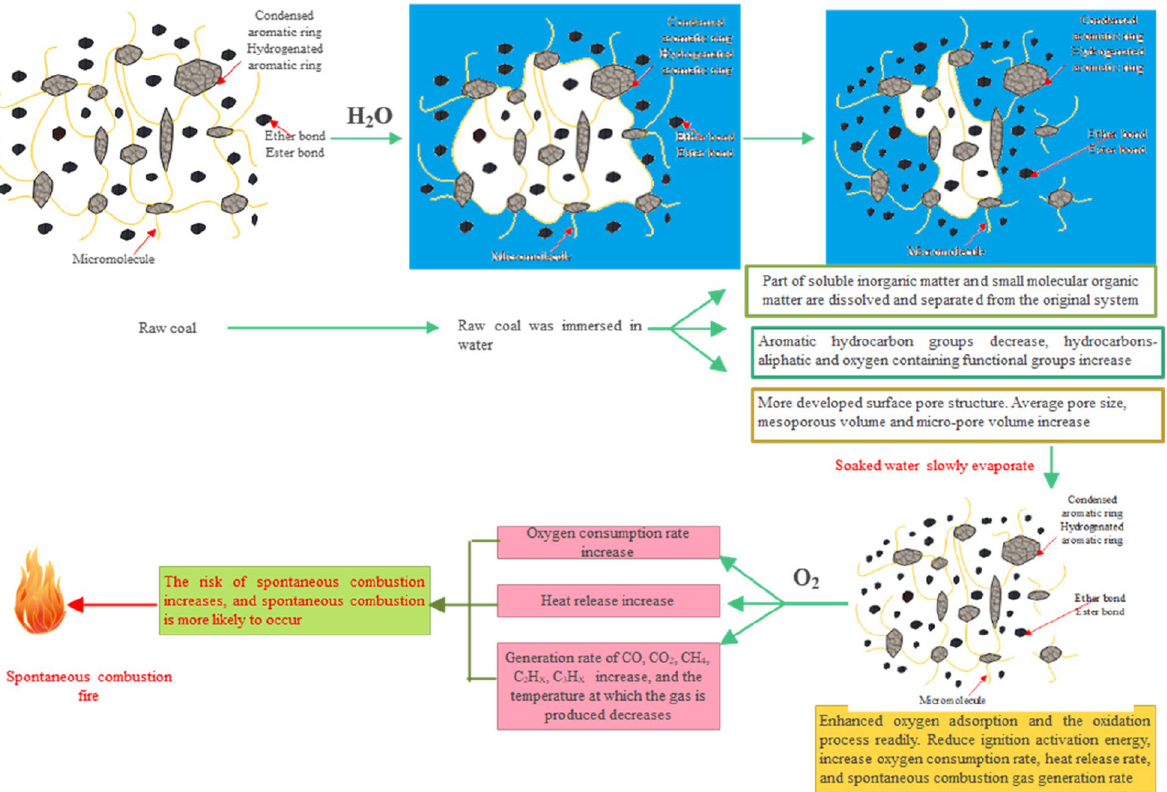
Figure 1. Effect of water immersion and drying on the spontaneous combustion risk of